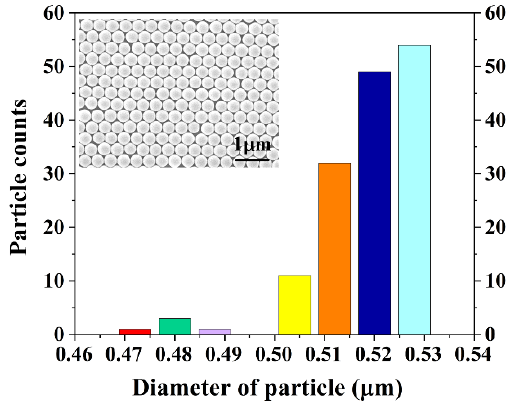
Figure 3. The size distribution of PS nanospheres (The inset is the SEM image of PS nanospheres).